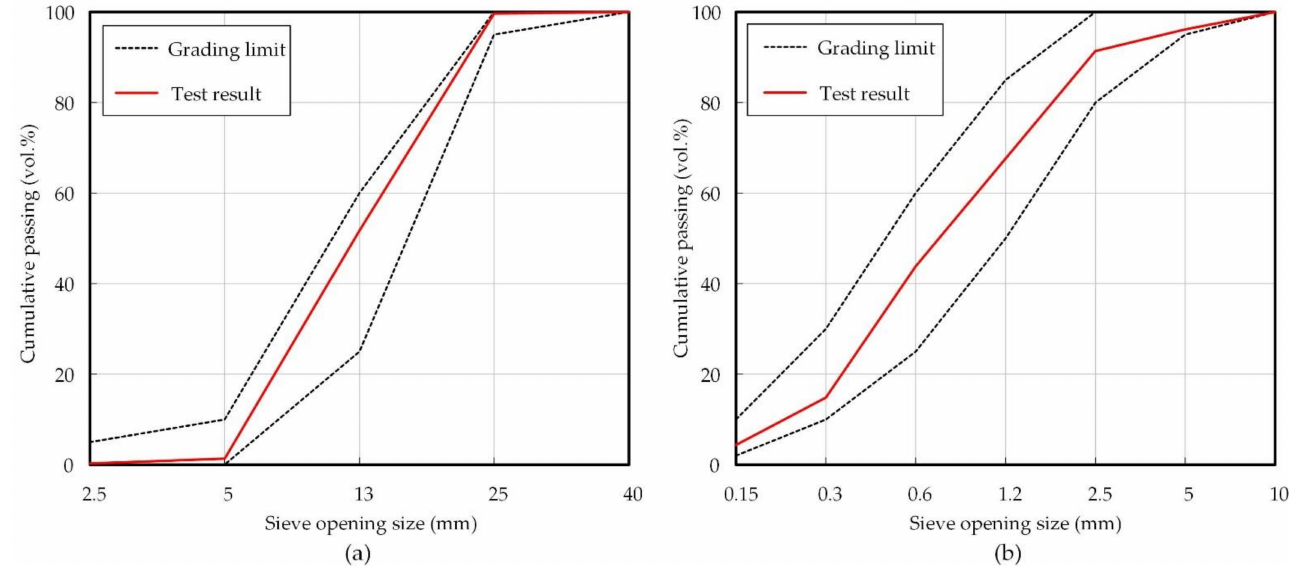
Figure 1. Gradation sieve curves of aggregates used: ( a ) coarse aggregates and ( b ) fine aggregates.